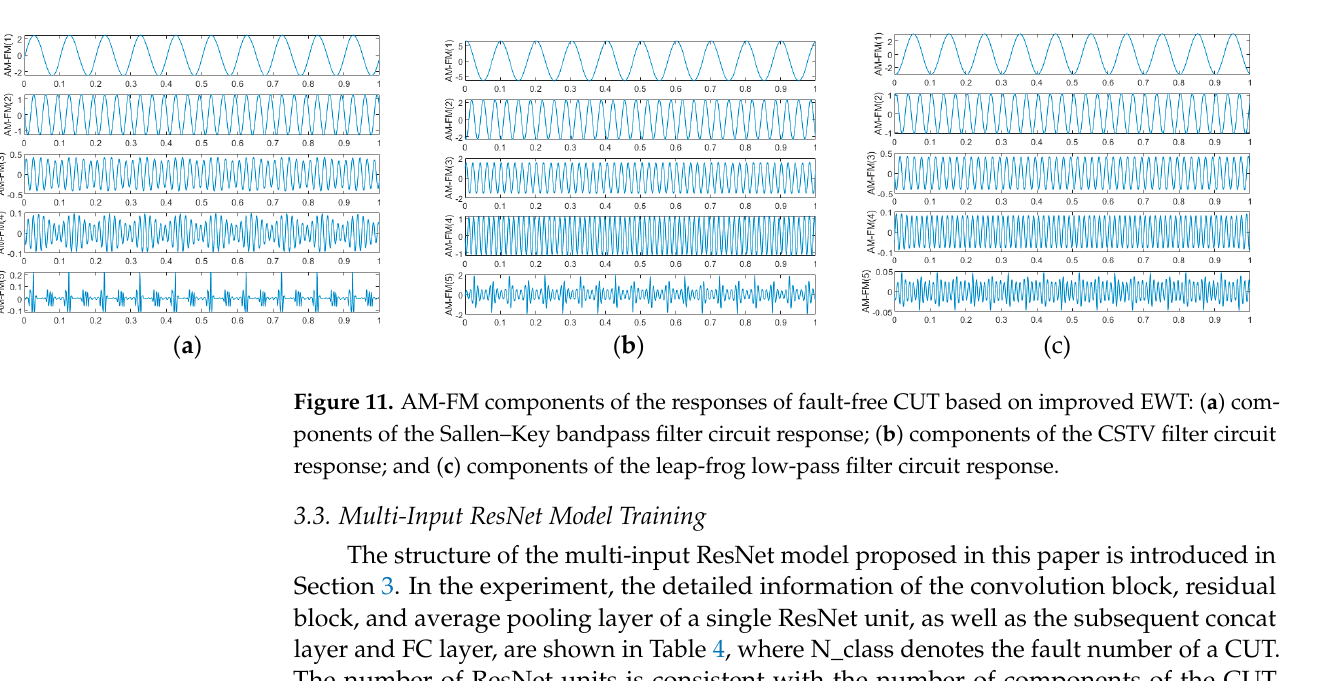
Table 4. Details of the multi-input ResNet.